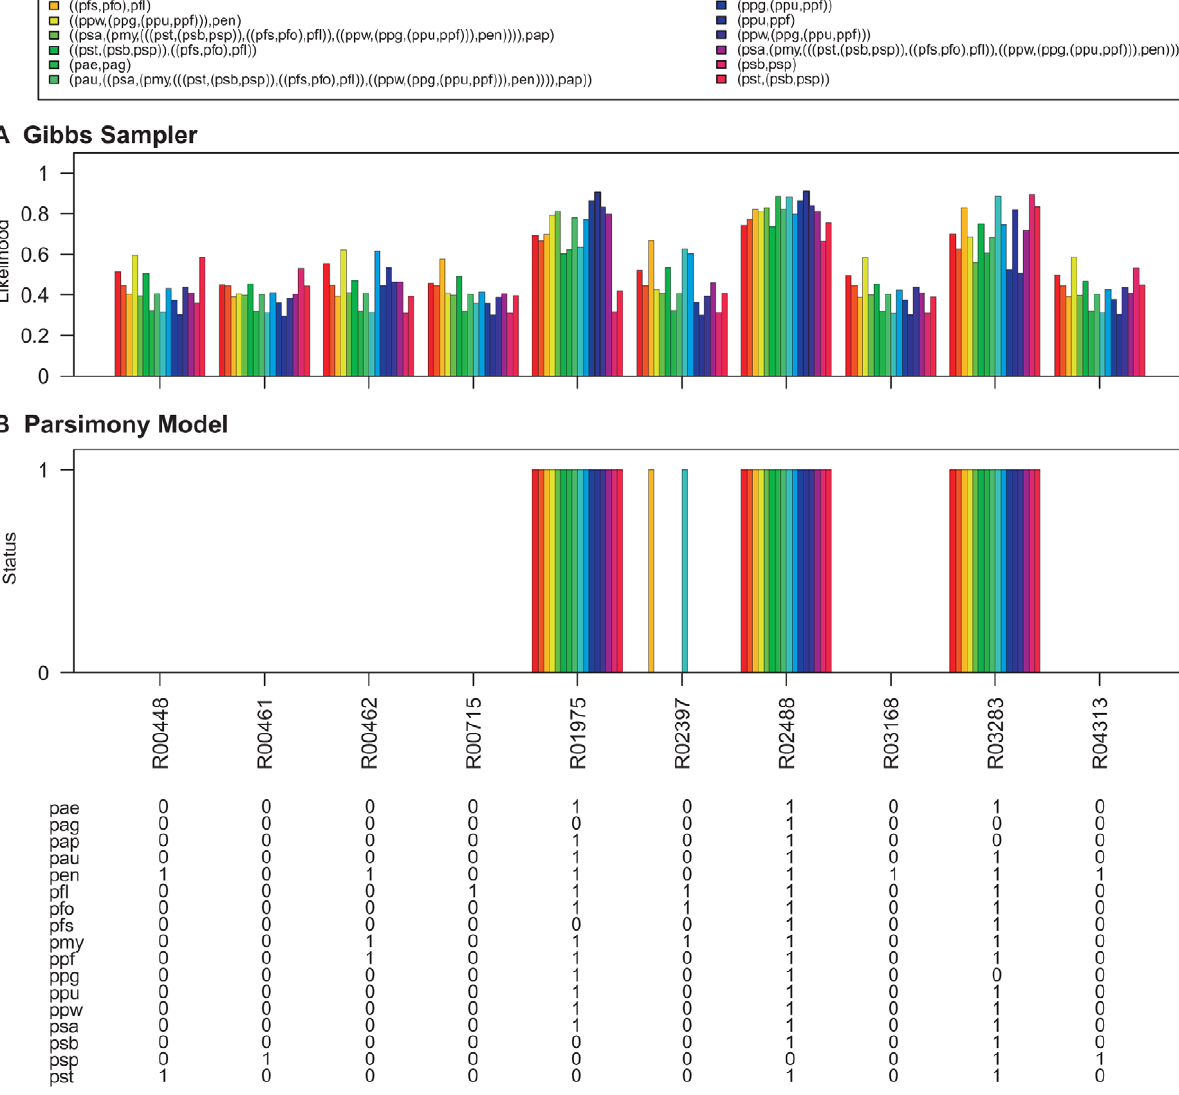
Figure 9. Ancestral network reconstruction for the lysine degradation map. The ancestral networks were reconstructed over the Pseudomonas phylogeny shown in Figure 6A. Also shown in the bottom panel is the distribution of reactions across different Pseudomonas strains. (A) Likelihood of being present for alterable reactions at various levels of Pseudomonas phylogeny obtained by calculating the proportion of times each hyperedge was present in the networks sampled by the Gibbs sampler. (B) Reaction status obtained under maximum parsimony calculated using the Fitch algorithm [26]. When assigning the reactions at the ancestral nodes the ties were resolved in favor of presence of reactions. Strain abbreviations: pae: P. aeruginosa PAO1, pap: P. aeruginosa PA7, pau: P. aeruginosa PA14, pag: P. aeruginosa LESB58, pen: P. entomophila L48, pfl: P. fluorescens Pf-5, pfo: P. fluorescens Pf0-1, pfs: P. fluorescens SBW25, pmy: P. mendocina ymp, ppf: P. putida F1, ppg: P. putida GB-1 ppu: P. putida KT2440, ppw: P. putida W619, psa: P. stutzeri A1501, psb: P. syringae pv. syringae B728a, psp: P. syringae pv. phaseolicola 1448A, and pst: P. syringae pv. tomato